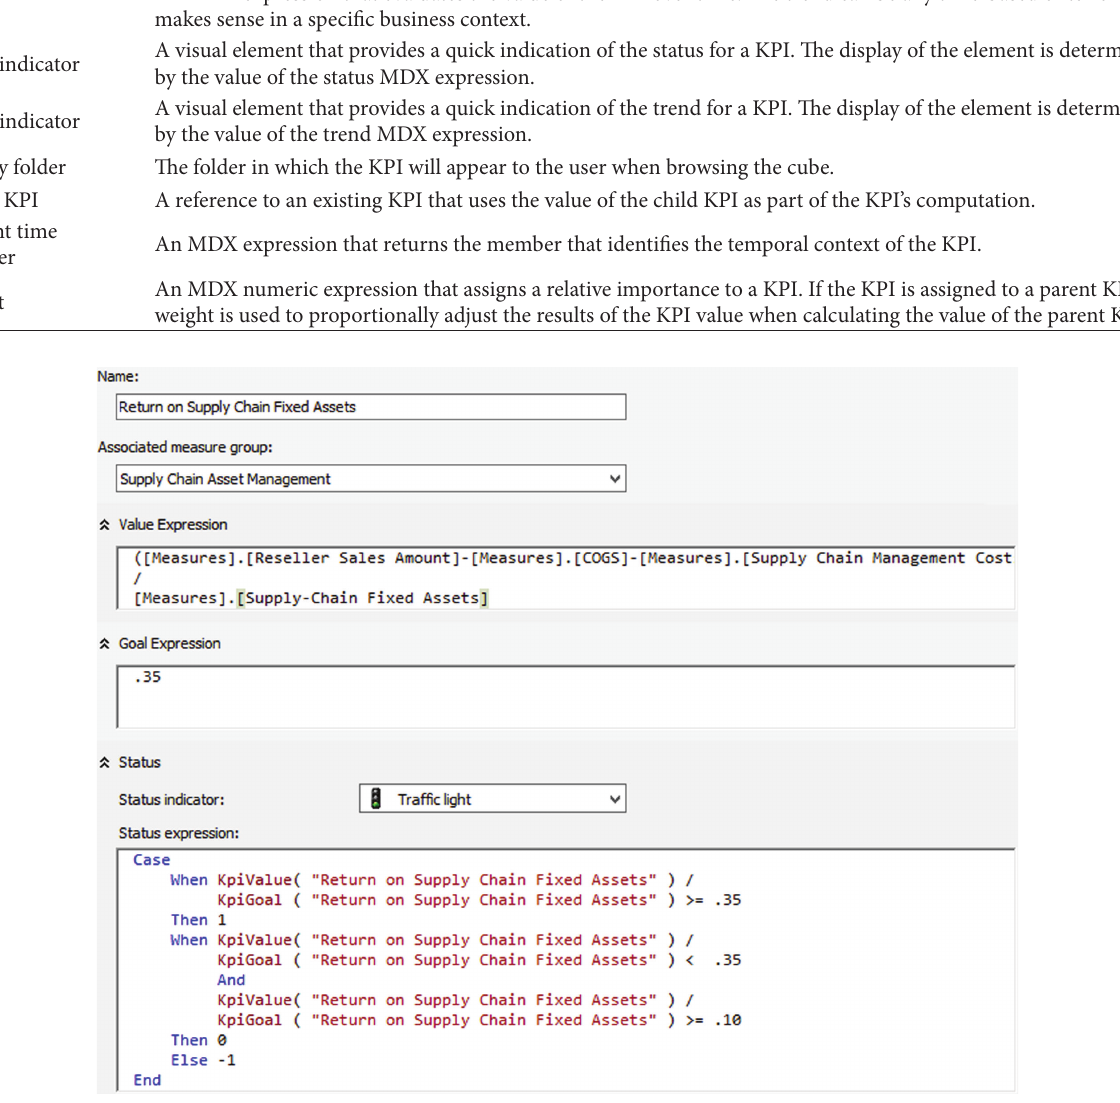
Figure 4: DX KPI